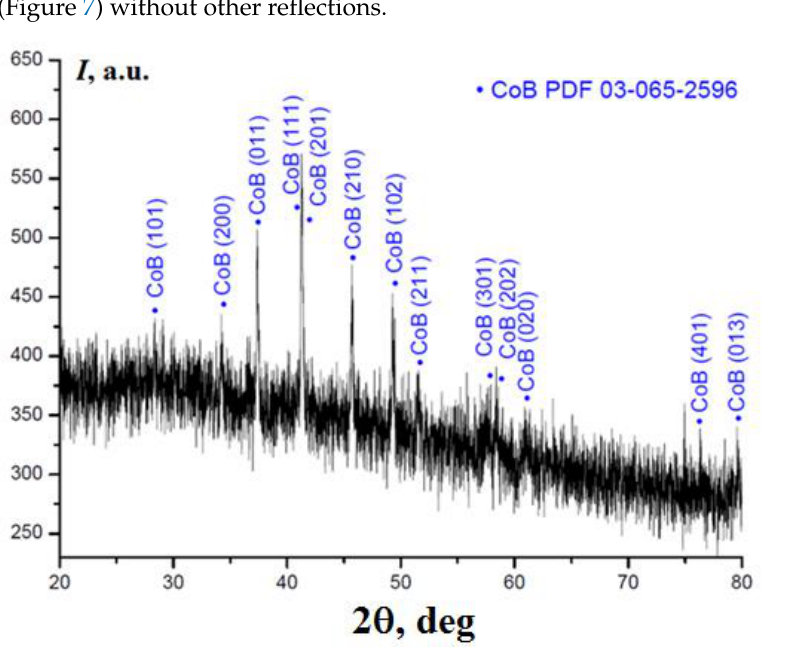
Figure 7. X-ray powder diffraction pattern for sample 3a .